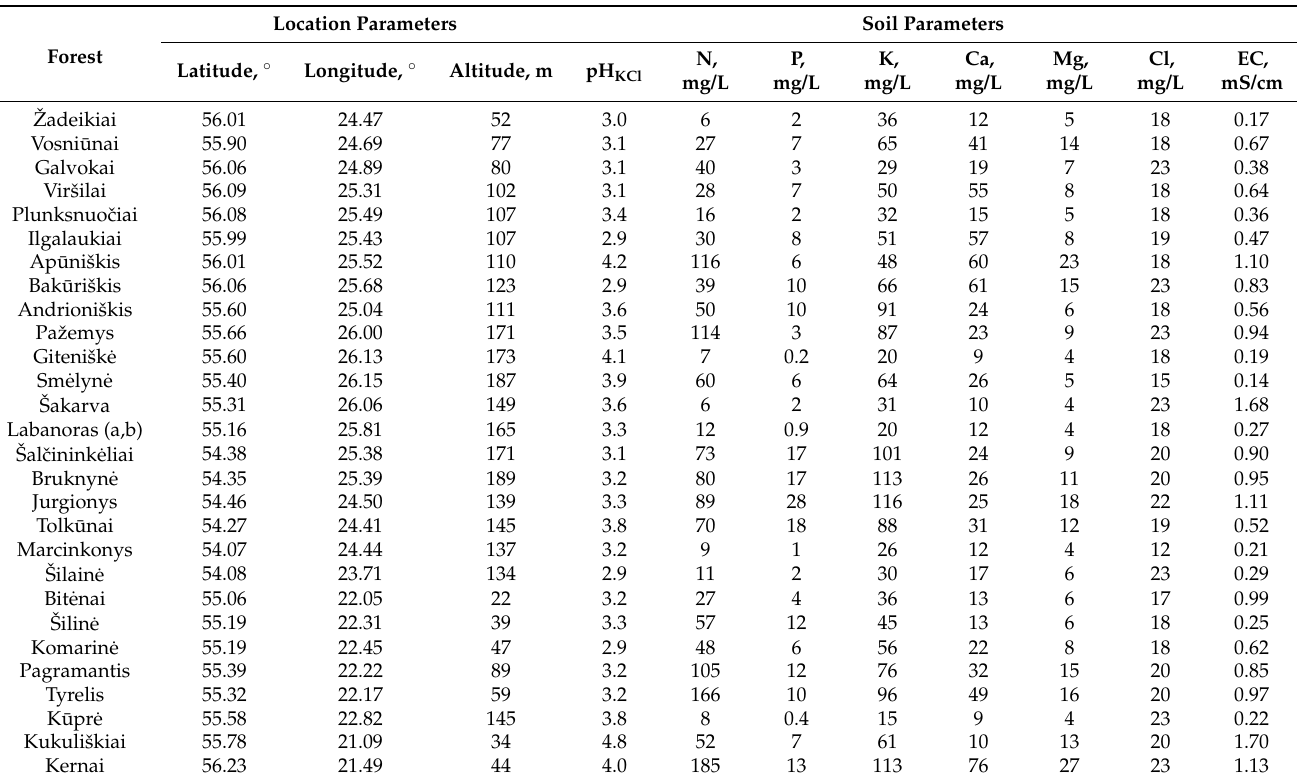
Table 1. Description of lingonberry leaves collecting locations and soil